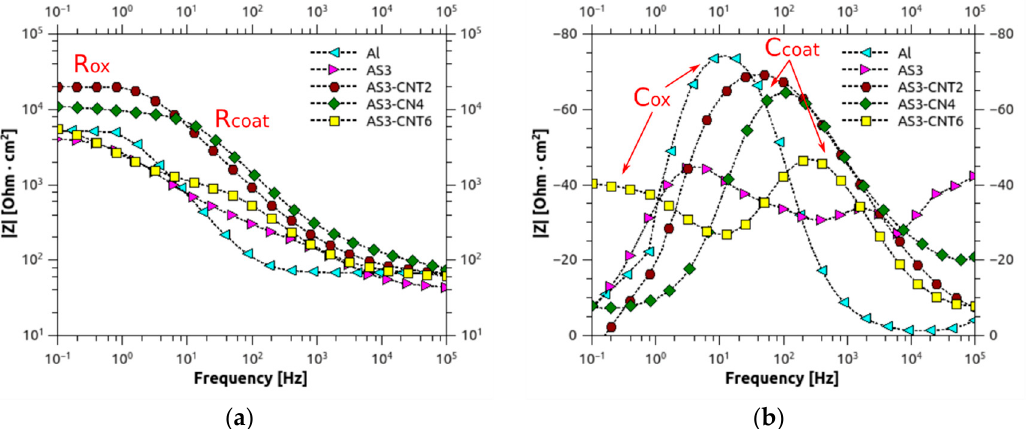
Figure 9. Bode plot of impedance modulus ( a ) and phase angle ( b ) of CNT filled and unfilled silane coating after 72 h of immersion in NaCl 3.5 wt.% solution.